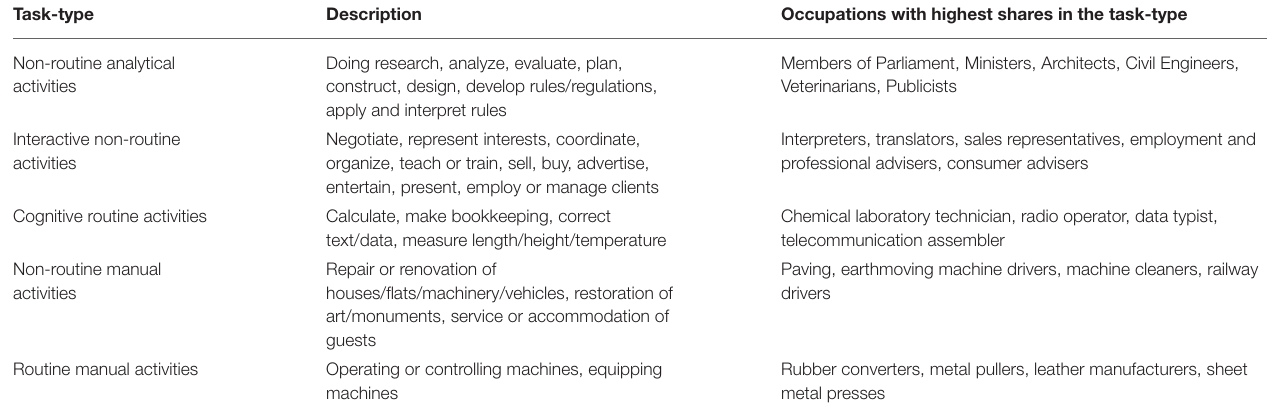
TABLE 1 | Task types of occupations and examples. Task-type